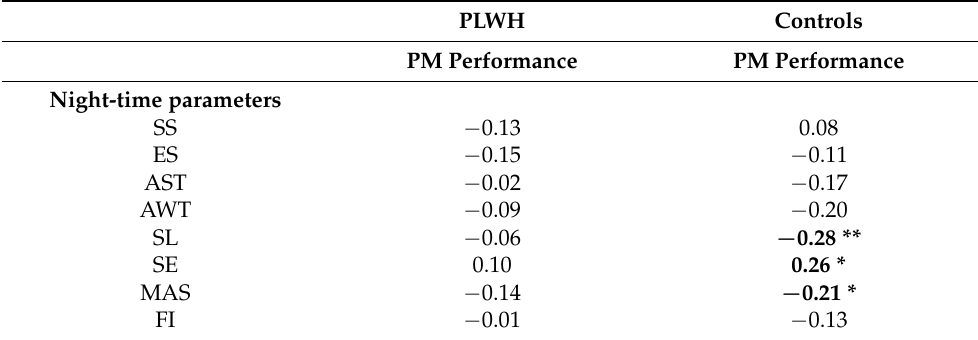
Table 2. Actigraphic night-time parameters and activity-based prospective memory performance at get-up time in persons living with HIV (PLWH) and controls.